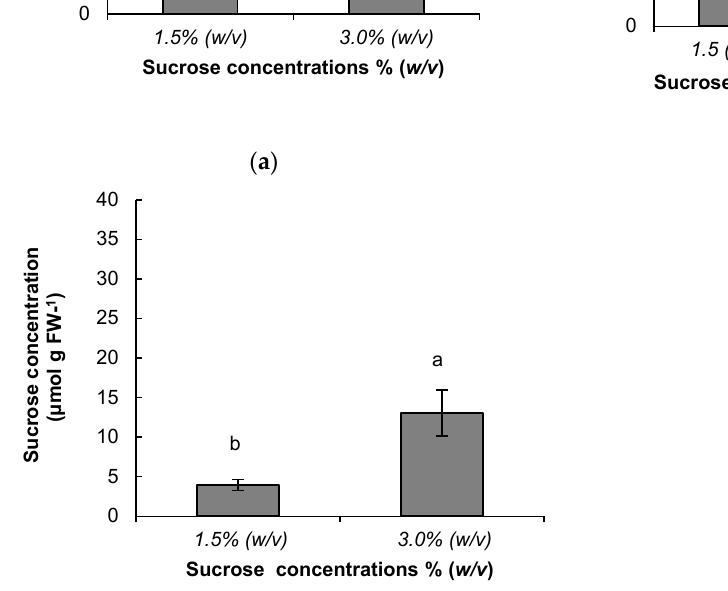
Table 2. Effect of 6-Benzyladenine (BA) (22 and 44 μ M) and sucrose concentration (1.5 and 3.0% ( w / v )) and light treatment (white fluorescent or red LEDs) on carbohydrate content of Pinus radiata D. Don shoots cultured in Quoirin and Lepoivre (LP) medium [27], modified according to Aitken- Christie et al. [28], supplemented with 2 gL − 1 activated charcoal after the rooting phase. BA Concentration (µM) Light Treatment Sucrose Concentration ( w / v ) Carbohydrates (µmol g FW − 1 ) Retention Time (min) 22